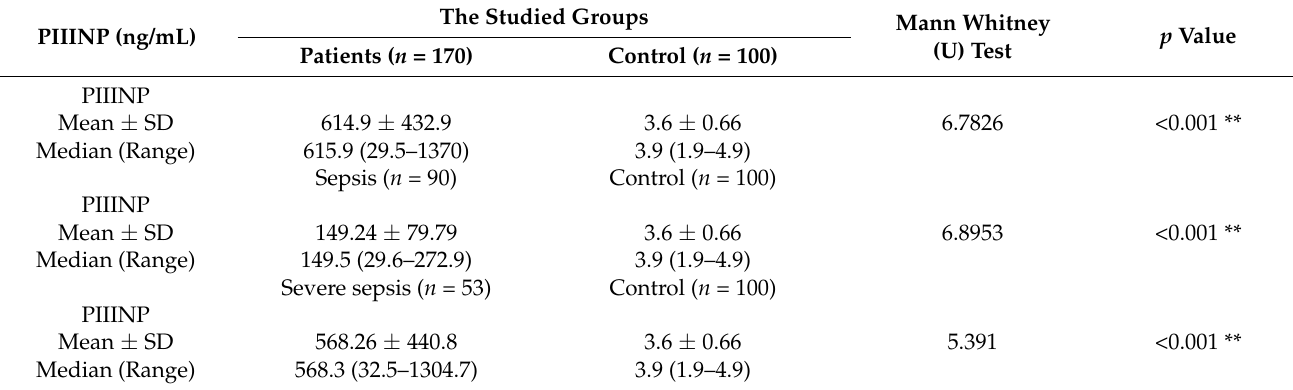
Table 3. Serum PIIINP level in the studied groups, subgroups, and